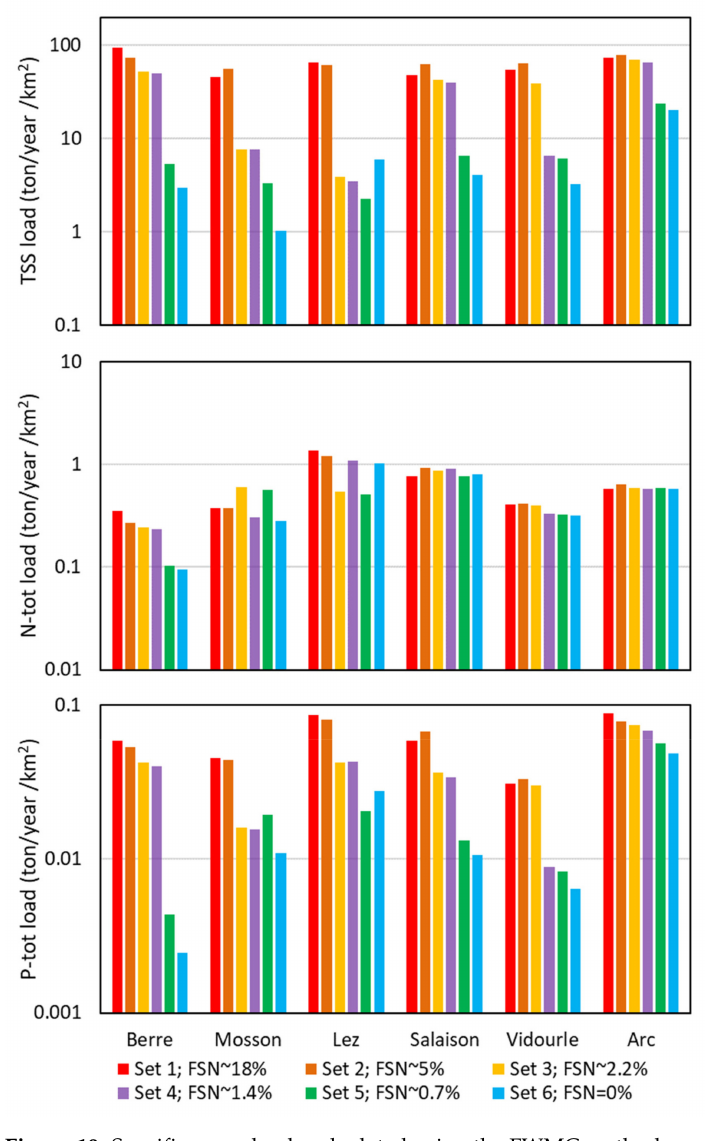
Figure 19. Specific mean loads calculated using the FWMC method considering different numbers of flood samples (FSN) expressed as percentage of the total number of